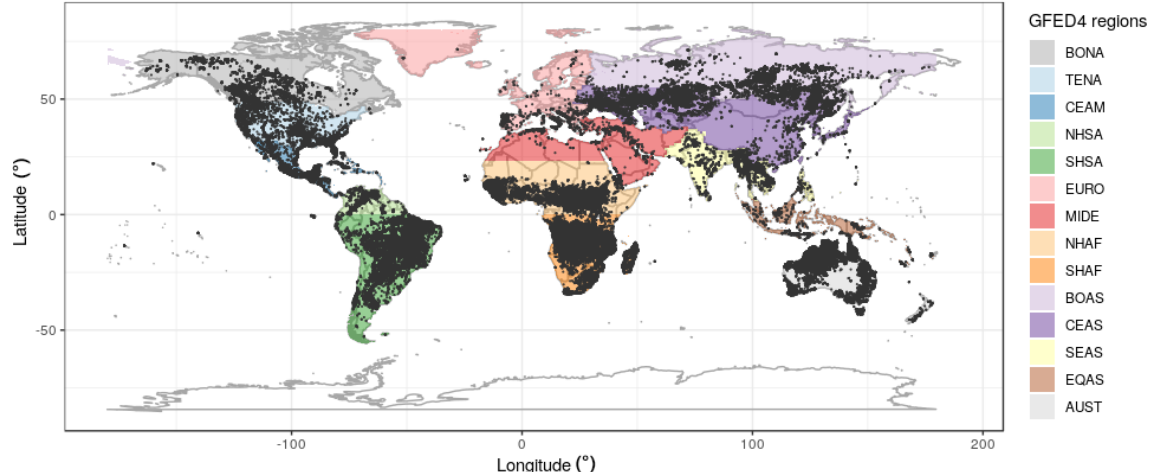
Figure 6. GFED4 micro-regions with the locations of all the 2017 events reported as active fires using the FRP observations from MODIS ingested into the GFAS